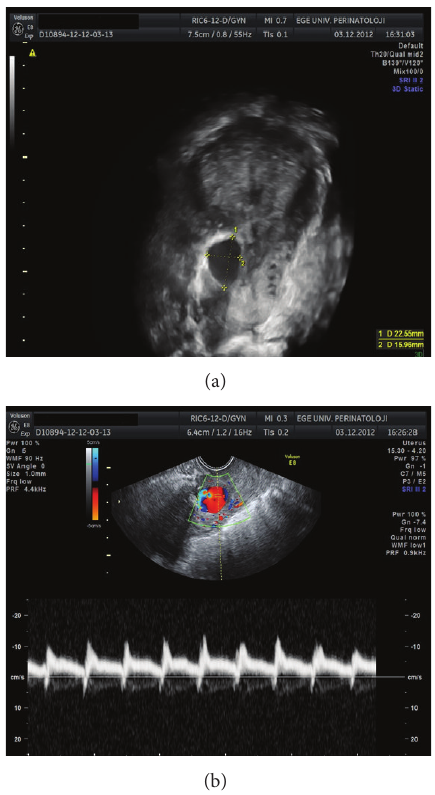
Figure 2: A cystic mass was observed on the right lateral isthmic region with a size of 22 × 16mm on gray scale and 3D sonography. Color flow and spectral Doppler imaging of the cystic mass revealed marked aliasing and bidirectional flow representing systolic and diastolic blood